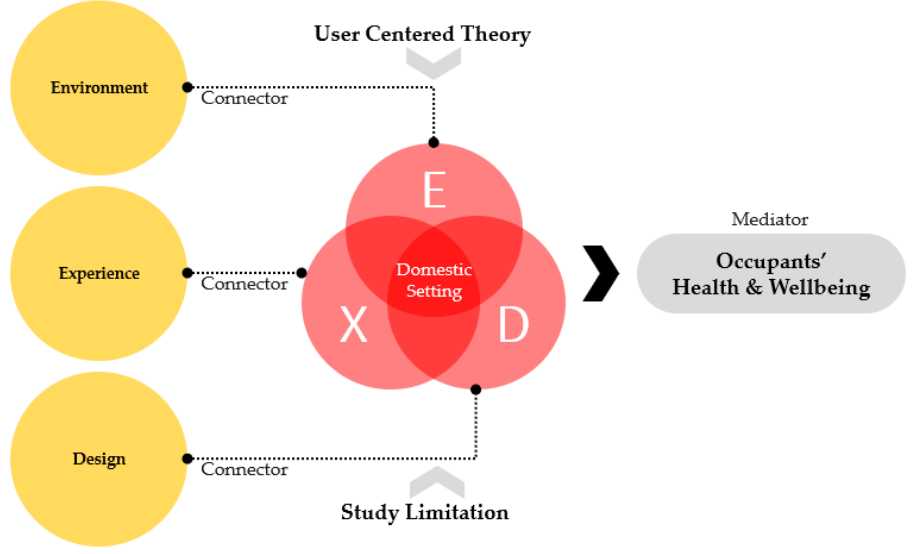
Figure 13. Domestic 'environmental experience design'.